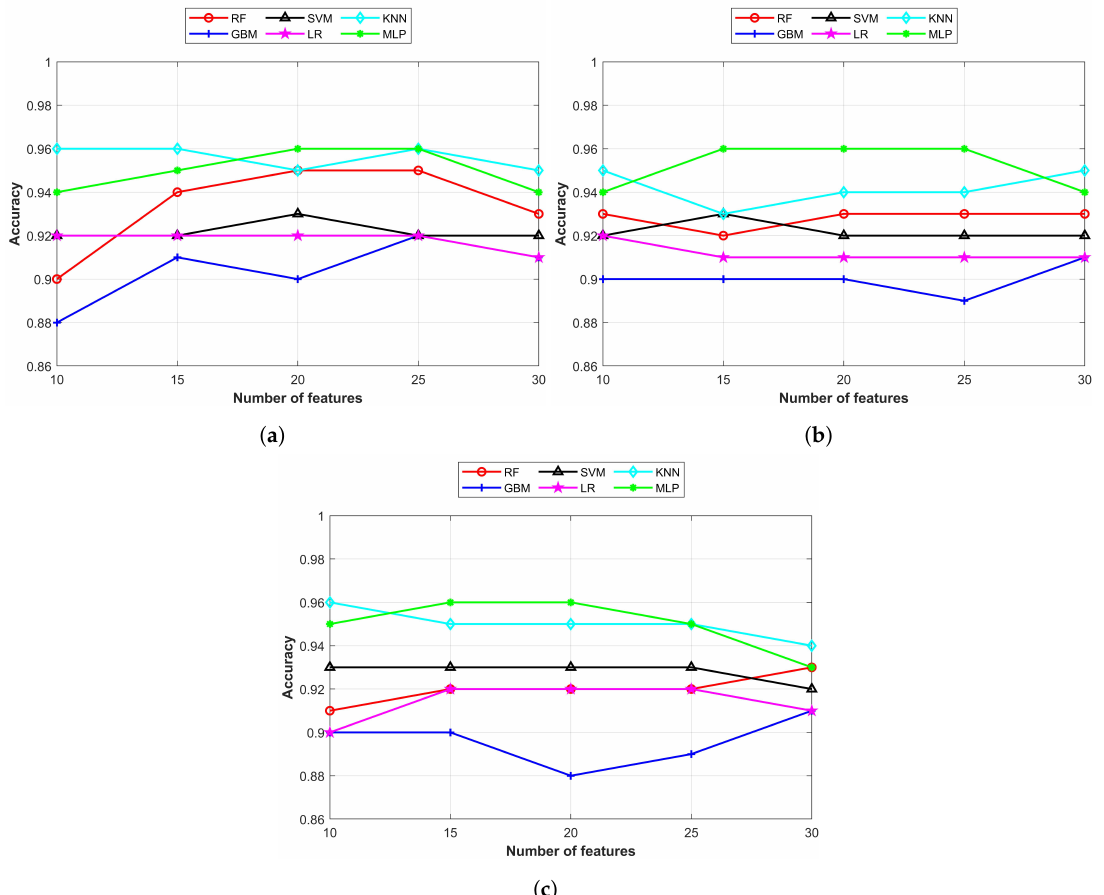
Figure 4. Comparison of classification accuracy using various number of features: ( a ) features using the Chi2, ( b ) SVD, and ( c ) PCA feature selection